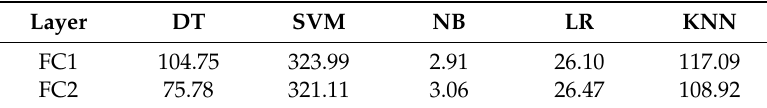
Table 2. Training time.